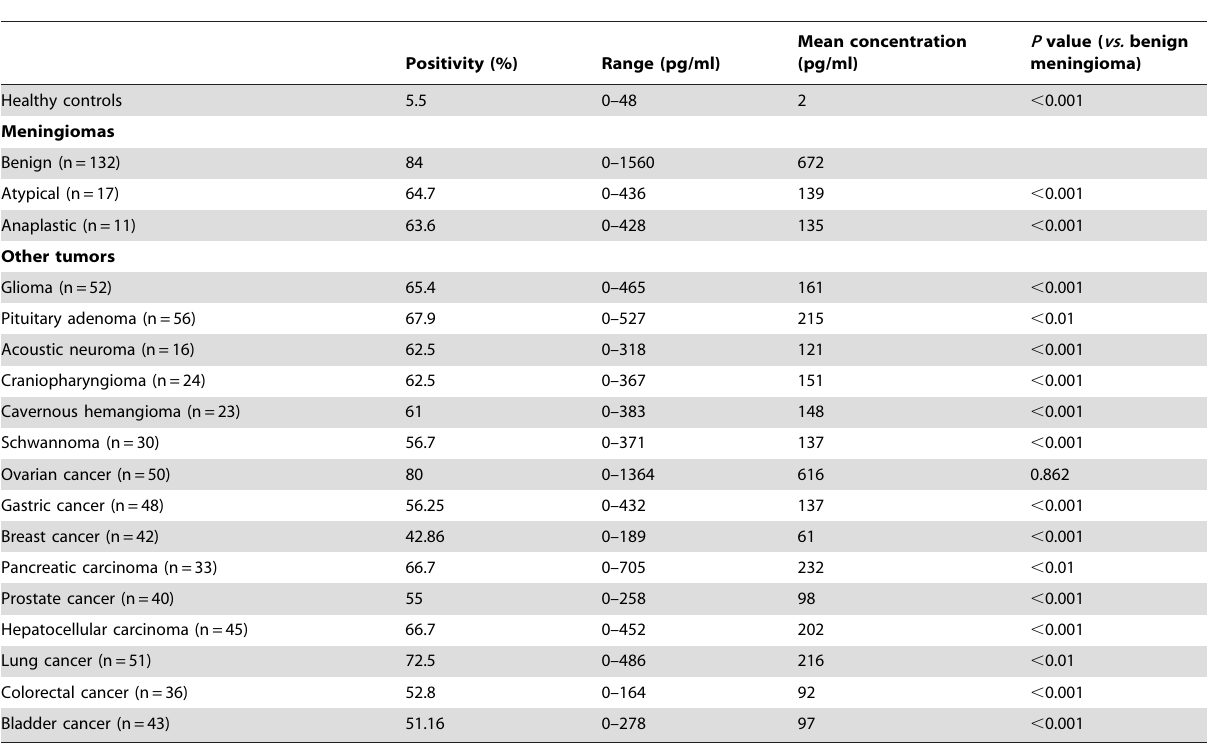
Table 1. Serum EGFL6 levels in healthy controls and patients with various tumors.